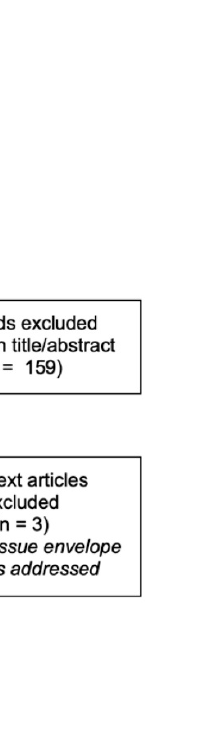
Figure 1: Literature search flow